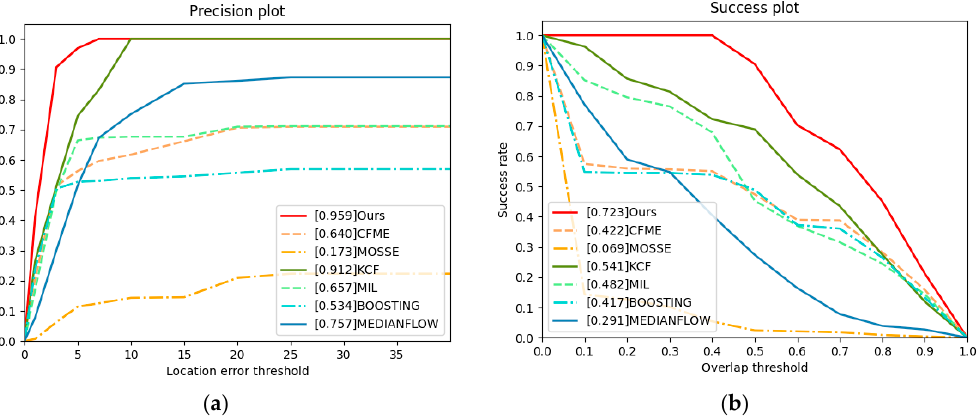
Figure 10. Precision plot and success plot. The values in legends are the AUC. ( a ) Precision plot of video4. ( b ) Success plot of